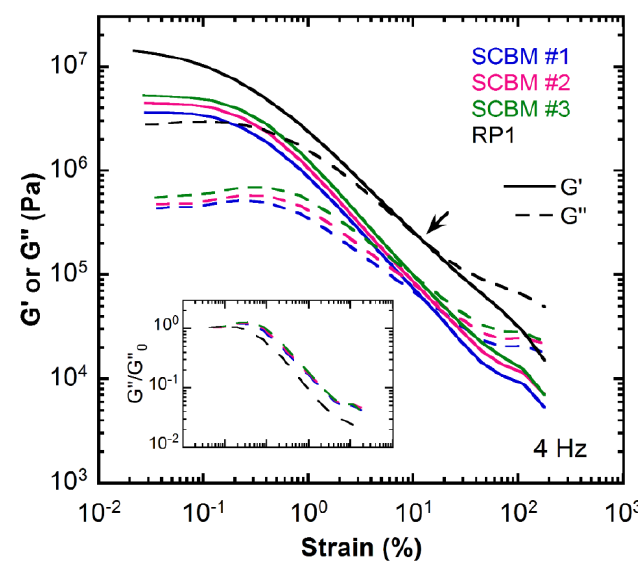
Figure 2. Dynamic shear storage modulus ( G ’, solid lines) and loss modulus ( G ”, dashed lines) as a function of strain amplitude measured at 4 Hz and 25 ◦ C for the SCBM materials and the RP1 clay. The arrow indicates the crossover strain (strain at G ’ = G ”) for the RP1 clay. The inset figure shows reduced loss modulus ( G ”/ G 0 ” as dashed lines, where G 0 ” is taken as the loss modulus at the smallest strain) as a function of strain amplitude. Colors are the same as in Figure 1. The measurement uncertainty in G ’ and G ” data are ± 3% and ± 10%, respectively. View in color for best clarity. The crossover strain obtained from the strain sweeps is plotted against frequency in Figure 3.